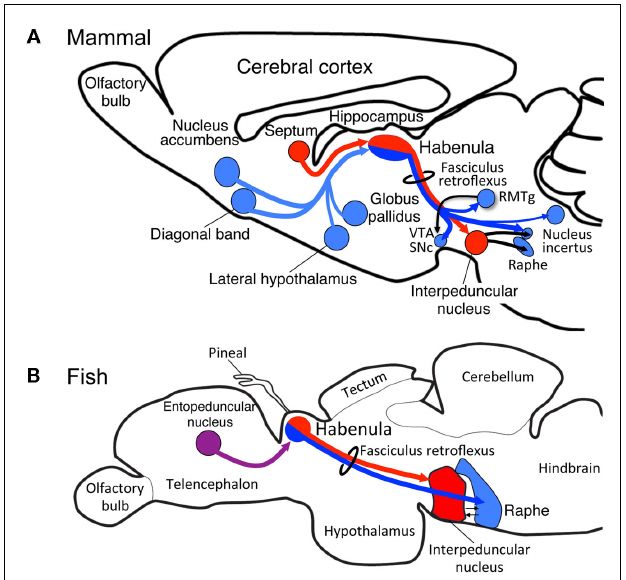
FIGURE 1 | Evolutionary conservation of the medial and lateral habenular pathways in vertebrates. Schematic diagram of sagittal sections from rat (A) and zebrafish (B) showing homologs for the medial (red) and lateral (blue) habenular circuitries.The entopeduncular nucleus [purple in (B) ] sends axons to the habenula in zebrafish, although the target of those axons within the habenula remains unclear. RMTg, rostromedial tegmental nucleus; SNc, substantia nigra, pars compacta;VTA, ventral tegmental area.